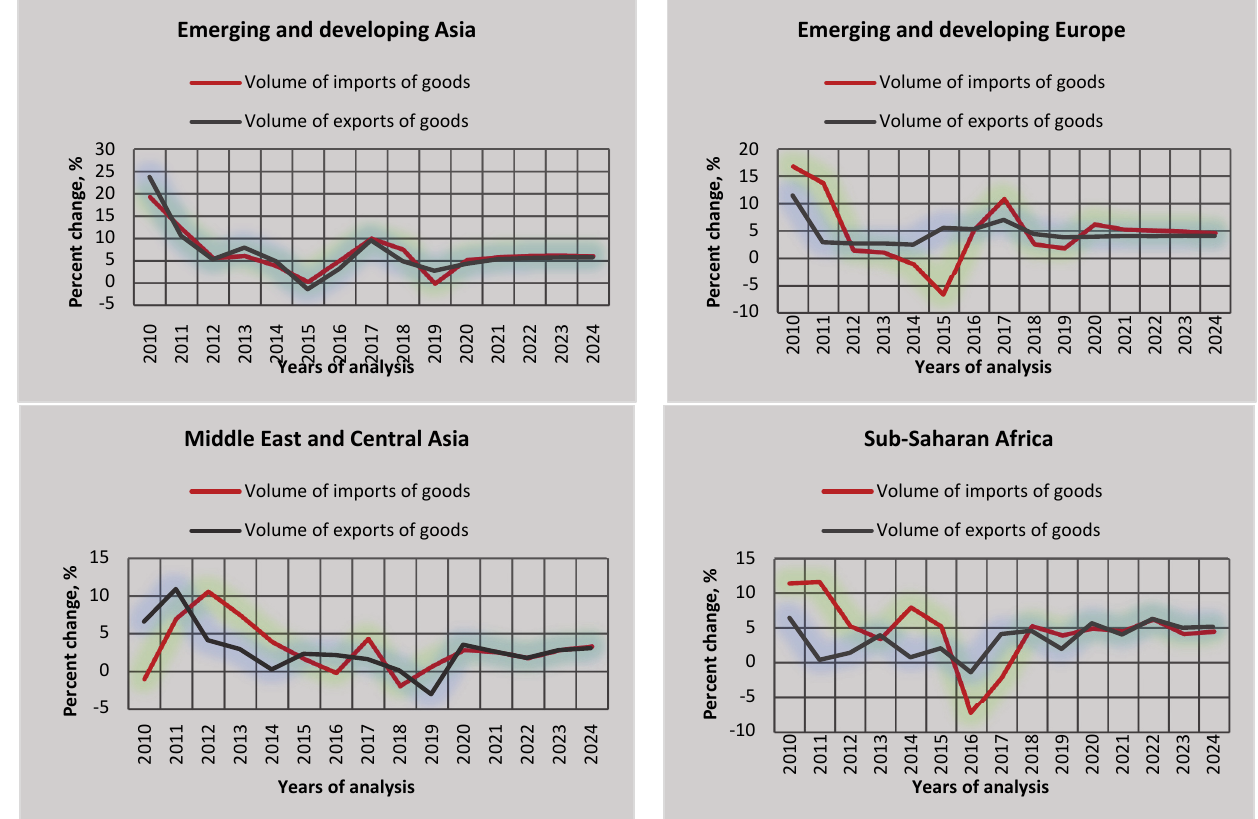
Fig. 2 . Tendency of export and import of goods with forecast component (differentiation groups). International Monetary Fund, World Economic Outlook Database, October 2019.